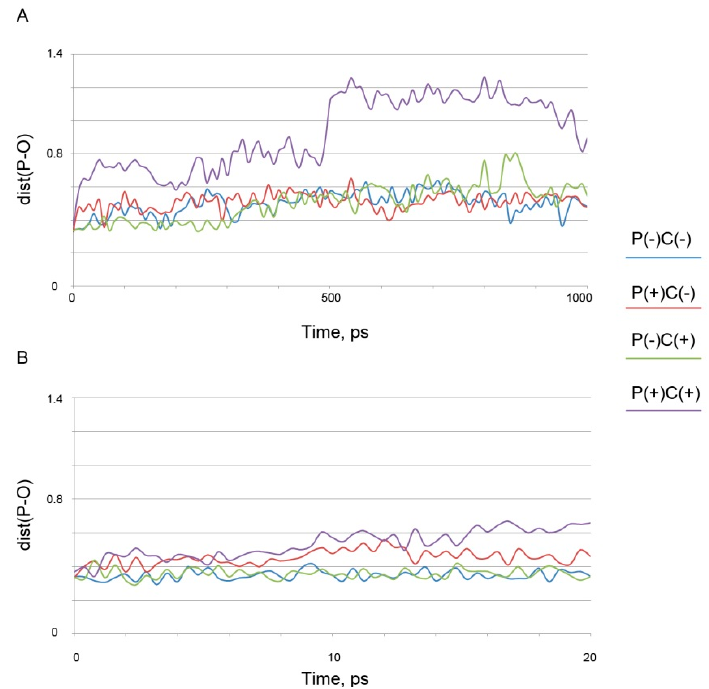
Figure 2. Molecular dynamics simulation time dependence of the distance between the phosphorus atom of soman and the hydroxyl oxygen of Tyr150 (dist(P-O)): the total trajectory ( A ) and the first 20 ps of the simulation ( B ).